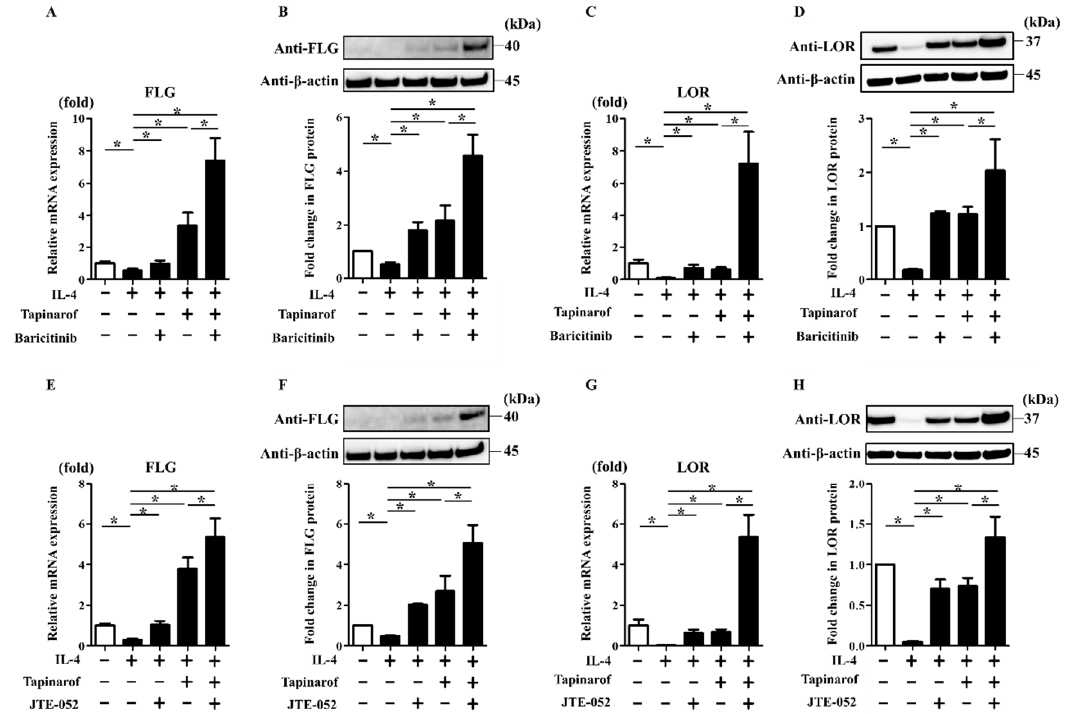
Figure 5. JAK inhibitors enhanced the reversing effects of tapinarof on the FLG and LOR downregulation induced by IL-4. NHEKs were treated with IL-4 (50 ng/mL) in the presence or absence of baricitinib (1 µM) and tapinarof (500 nM) ( A – D ) or JTE-052 (1 µM) and tapinarof (500 nM) ( E – H ) for 72 h for qRT-PCR and for 96 h for Western blotting analyses. ( A , C , E,G ) FLG and LOR mRNA expression was assessed by qRT-PCR. Representative data of three independent experiments with similar results are shown. ( B , D , F , H ) FLG and LOR protein expression was analyzed by Western blotting with anti-FLG and anti-LOR antibodies. ( Upper ) Representative blot images of three independent experiments with similar results are shown. ( Lower ) FLG or LOR protein levels are normalized to β -actin protein levels using ImageJ and expressed as fold change over the control group. ( A – H ) Error bars represent mean ± standard deviation; n = 3 for each group. Statistically significant differences are presented: * p < 0.05.